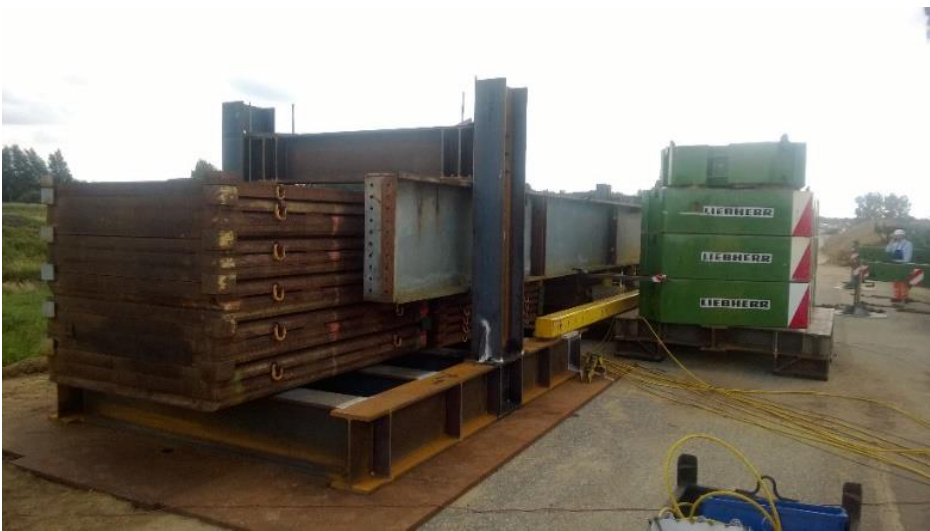
Figure 2. Applied classification loads used for the in situ tests. Standard vehicle A adjacent to standard vehicle B.